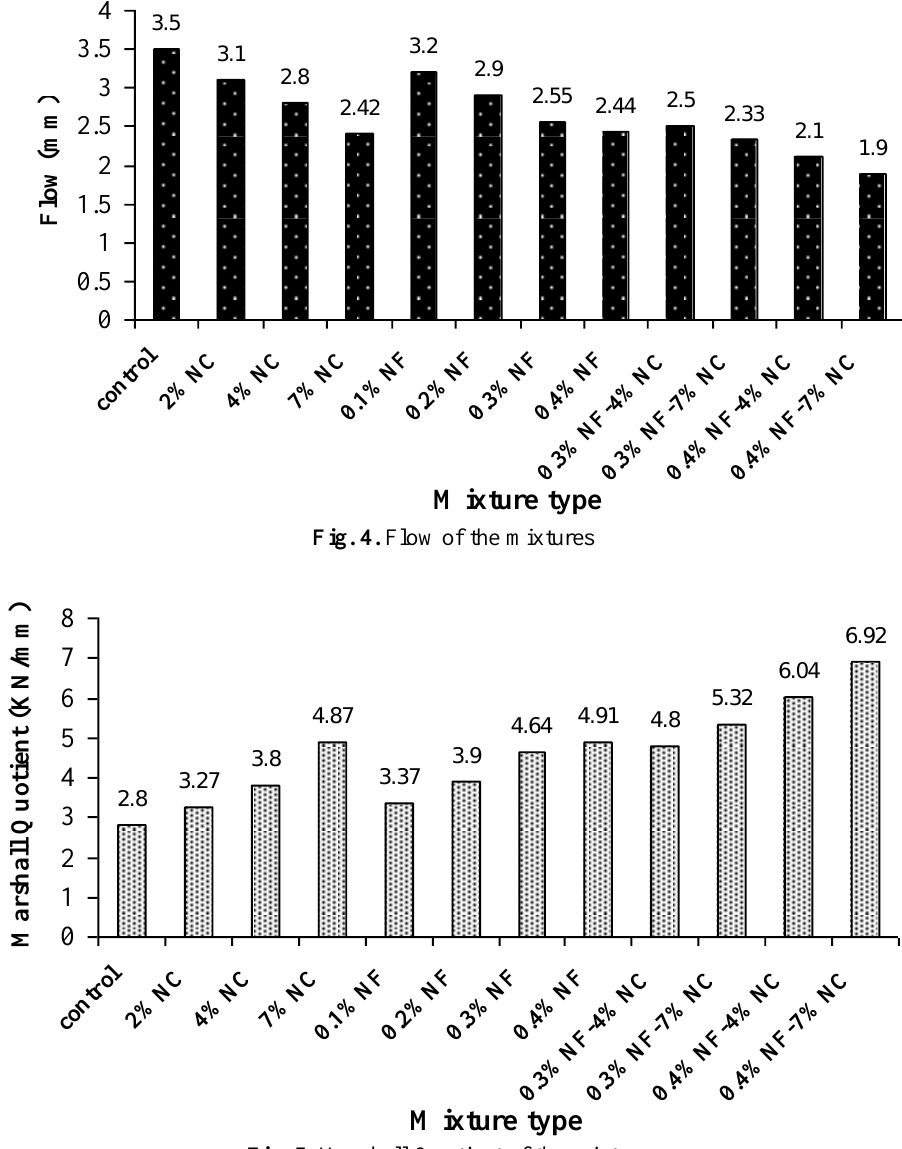
Fig. 5. Marshall Quotient of the